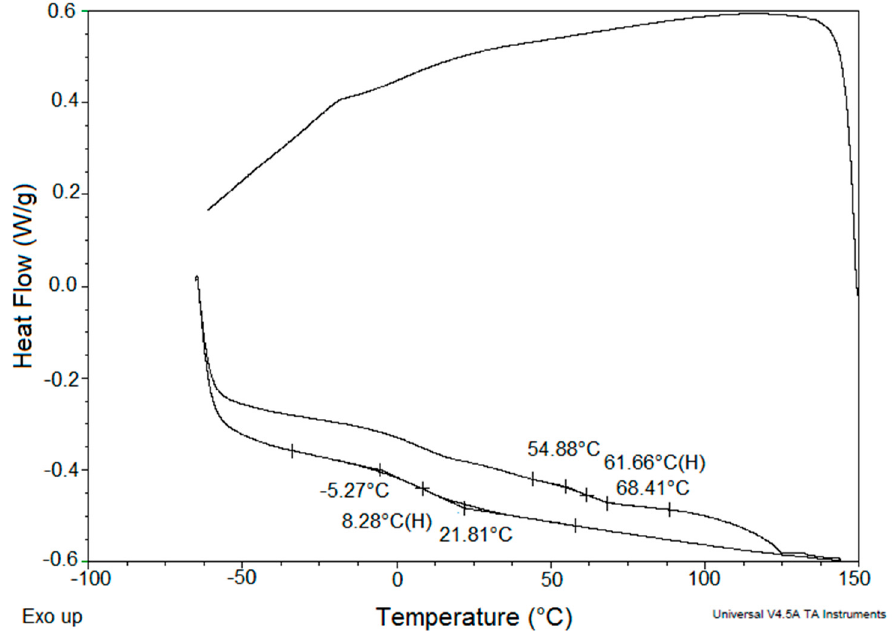
Figure 5. DSC record for the sample L MgO-1.0 containing MgO-based nanoparticles. Illustration of a second iso-phase transition appearing in the first heating curve.